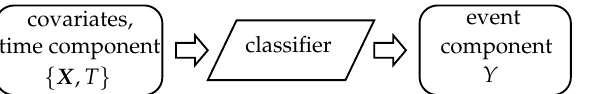
Figure 4. A logic of prediction based on a classification model. Covariates X = ( X 1 , X 2 , . . . , X k , T ) T on input are used for the classifier’s building, which enables us to estimate output, i.e., the event of interest’s occurrence Y (in time T and for specific values of other covariates X ). The classifier is an algorithm from the following set: { multivariate logistic regression , naïve Bayes classifiers , decision trees , random forests , artificial neural networks }